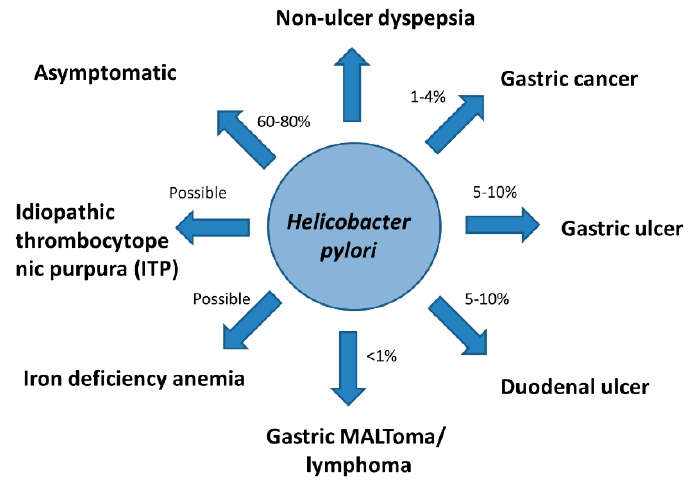
Figure 4. H. pylori and human diseases. H. pylori: Helicobacter pylori ; MALToma: mucosa-associated lymphoid tissue lymphoma.